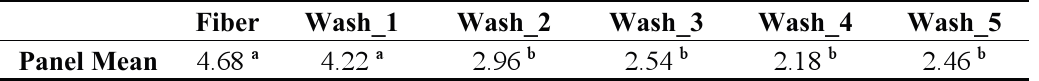
Table 2. Sensory panel mean of the cashew-like aroma in the fibrous residues. Fiber Wash_1 Panel